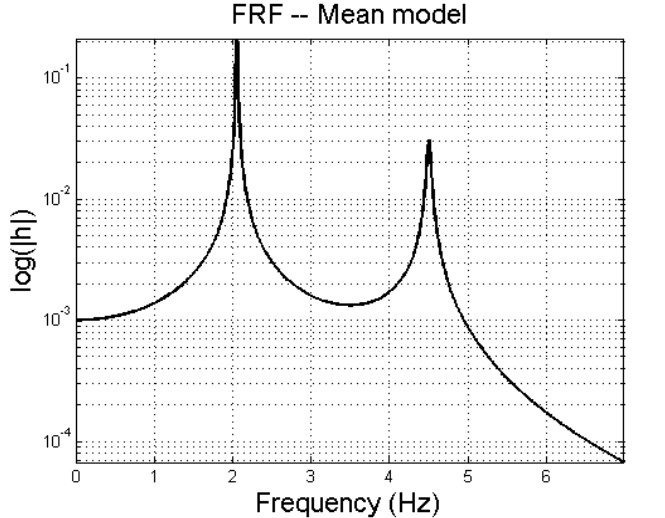
Fig. 2. FRF of the mean